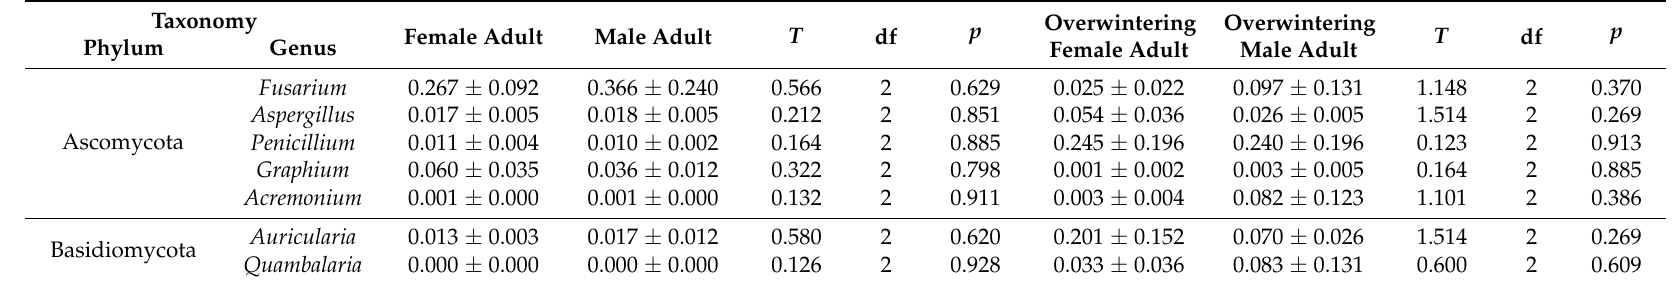
Table A5. The relative abundance of the different fungal taxa in different sexes of T. klimeschi at the genus level.